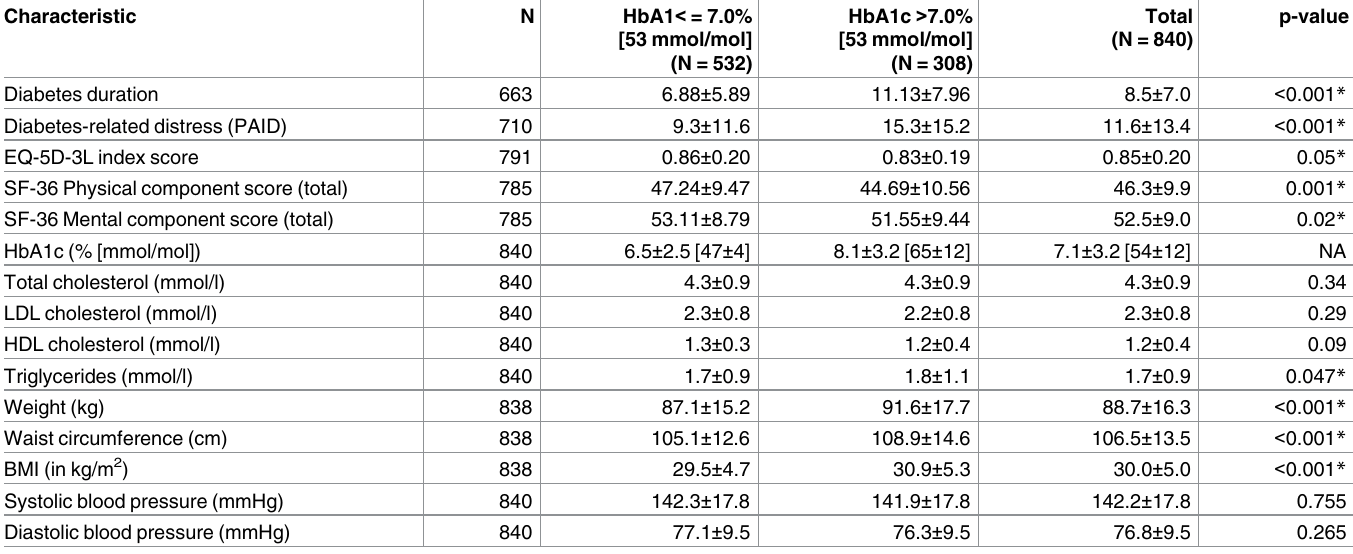
Table 3. Health-related patient characteristics by glycaemic control (continuous